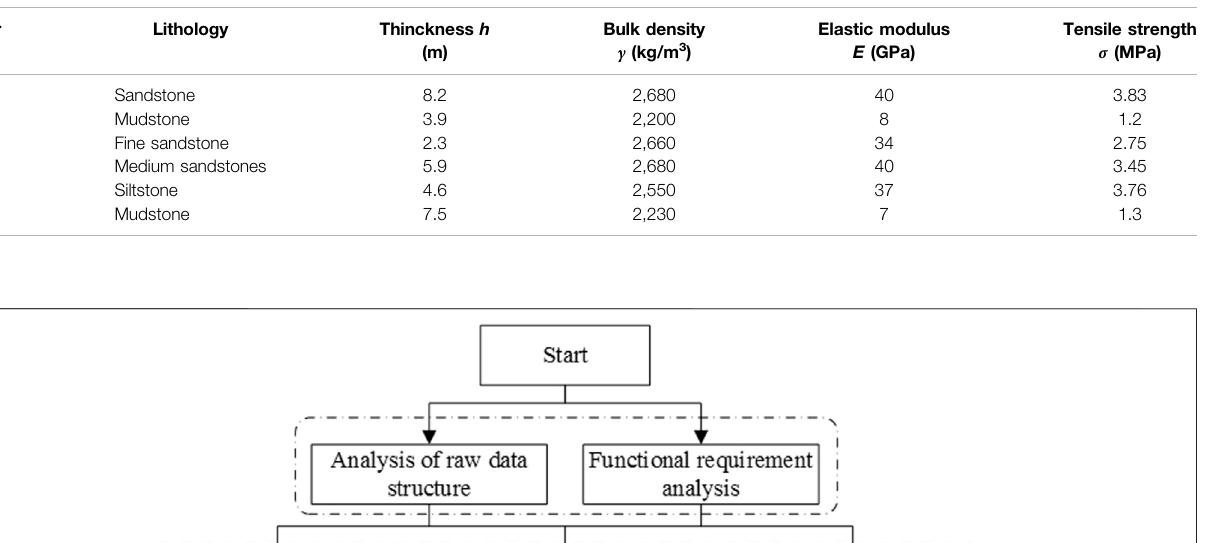
TABLE 1 | Format of lithology data.